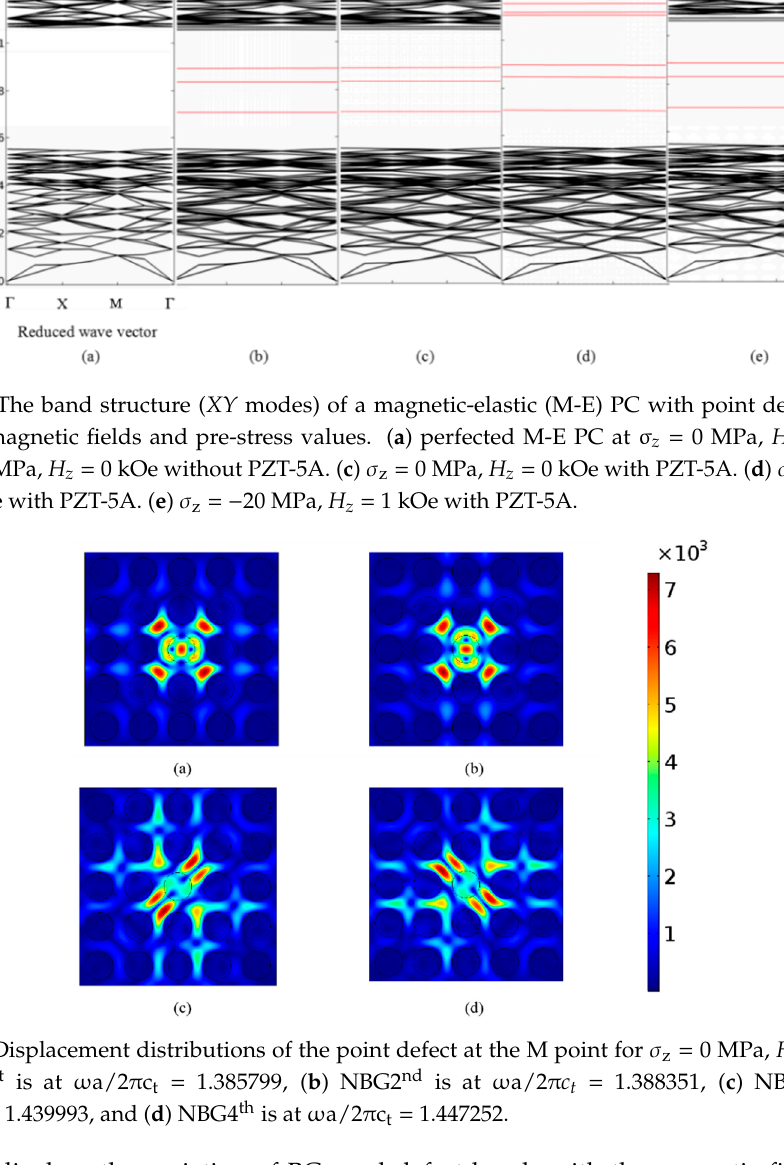
σ = 0 MPa, H = 1 kOe. z z